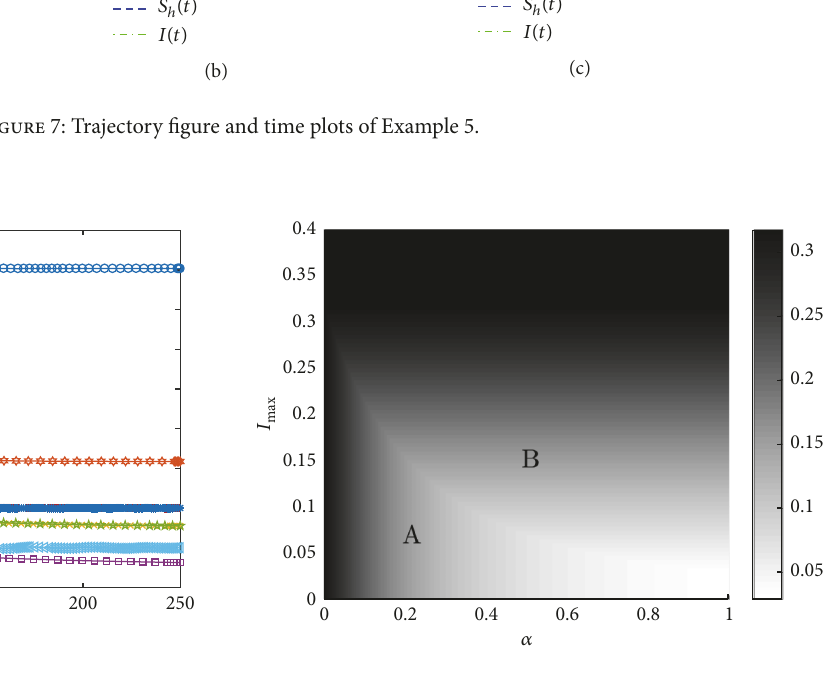
. 𝐼 max and 𝐼 are the final final is the final